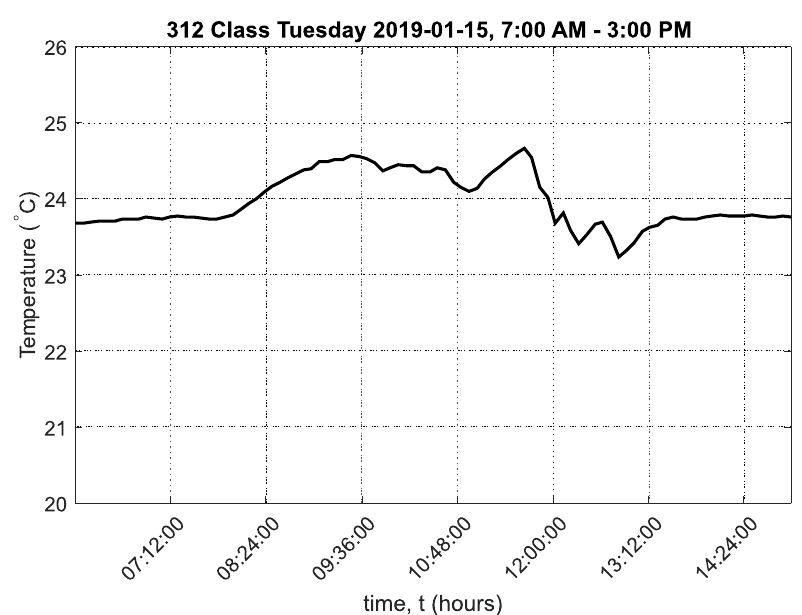
Figure A5. Graph of ambient temperature in classroom 312, Frenštát pod Radhoštˇem.